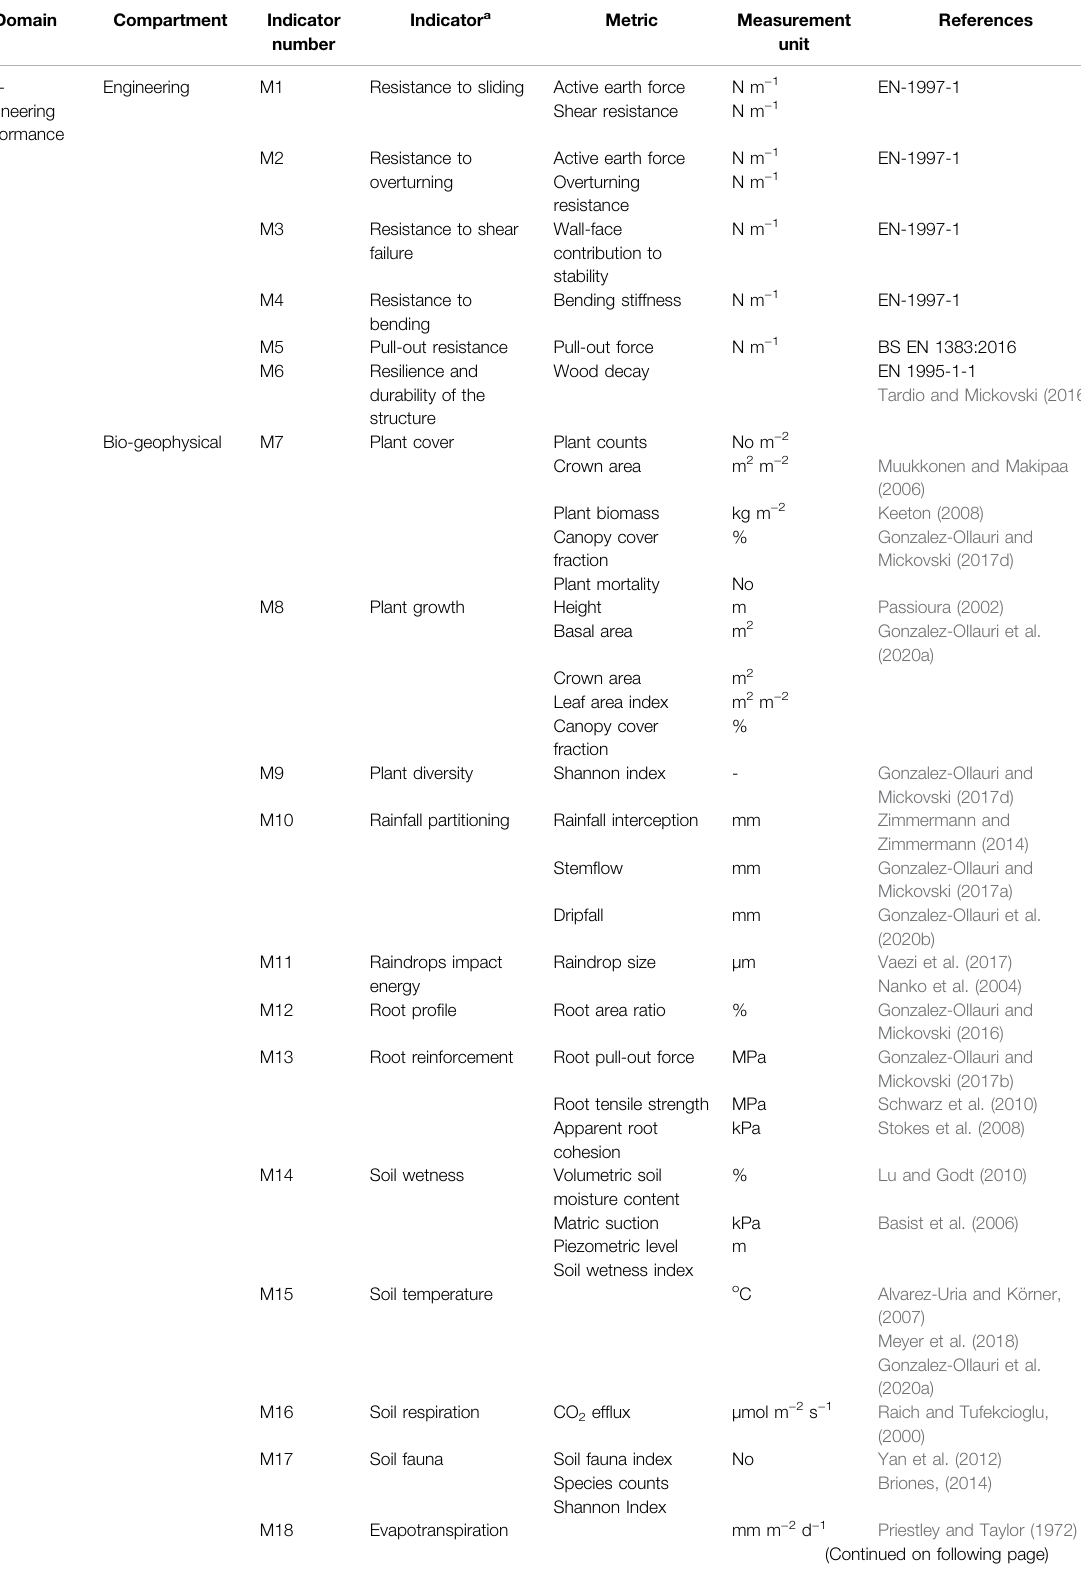
TABLE 1| Indicators repository originatingfrom the ‘ rocket framework ’ (Figures 2, 3) to monitor theperformance ofplant-based NBS against landslides and erosion at the monitoring stage